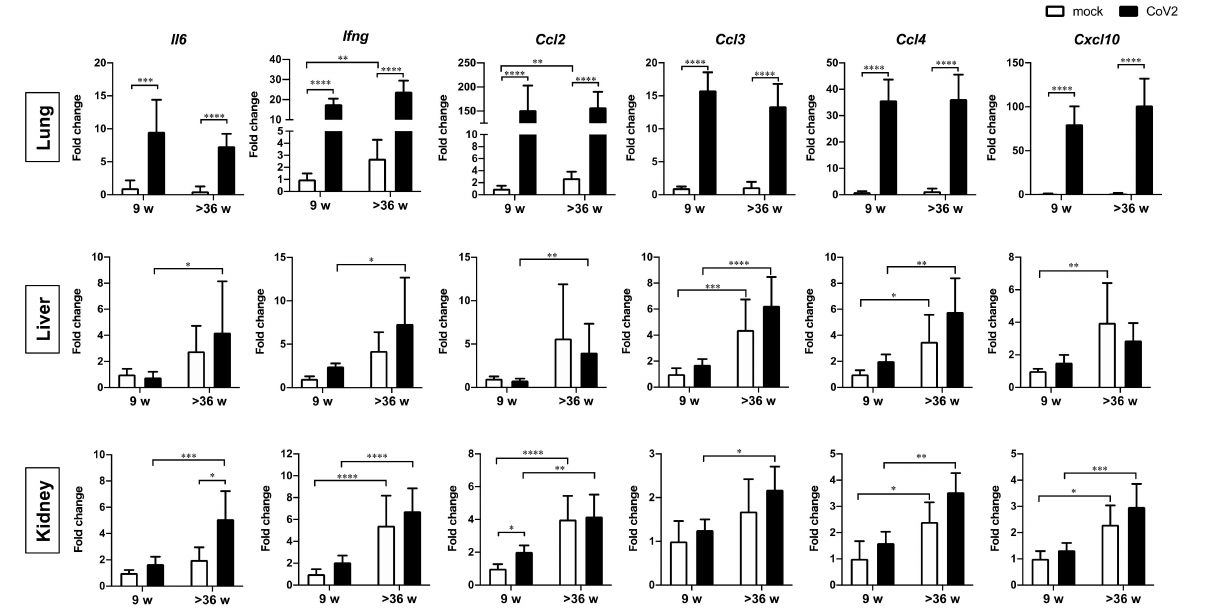
Figure 3. Gene expression of inflammatory factors in the lungs, liver, and kidneys of young and aged hamsters infected with CoV2. Young (9 w) and aged (>36 w) hamsters were intranasally inoculated with PBS control (mock) or PBS containing SARS-CoV-2 virus (CoV2), and the hamsters were euthanized at 6 days post infection for the collection of lung, liver, and kidney samples for measurement of the expression of inflammatory factor genes. Gene expression levels of interleukin-6 ( Il6 ), interferon-gamma ( Ifng ), C-C motif chemokine 2 ( Ccl2 ), Ccl3 , Ccl4 , and C-X-C motif chemokine ligand 10 ( Cxcl10 ) are presented as the fold changes relative to those of young mock hamsters. Bars represent the mean ± SEM [mock (9 w), n = 6; CoV2 (9 w), n = 11; mock (>36 w), n = 6; CoV2 (>36 w), n = 14]. White and black bars indicate data from control and CoV2-infected hamsters, respectively. * p < 0.05, ** p < 0.01, *** p < 0.001, **** p < 0.0001, two-way ANOVA on dCt values with Sidak’s multiple comparison